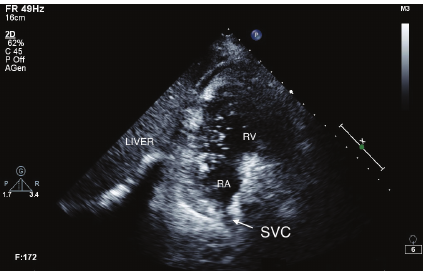
Figure 2: Echocardiography. Subcostal acoustic window: air bub- bles in right atrial and ventricular cavities. RA: right atrium; RV: right ventricle; SVC: superior vena cava.